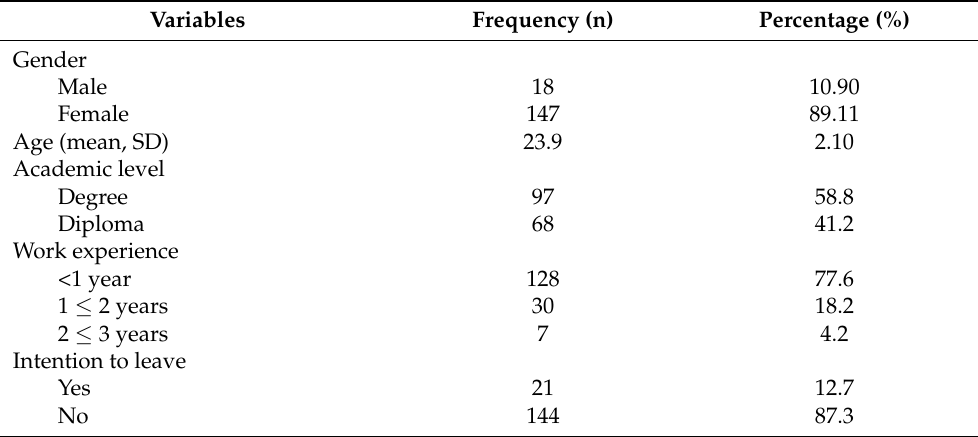
Table 1. Descriptive analysis of demographic characteristics and intentions to leave the nursing pro-